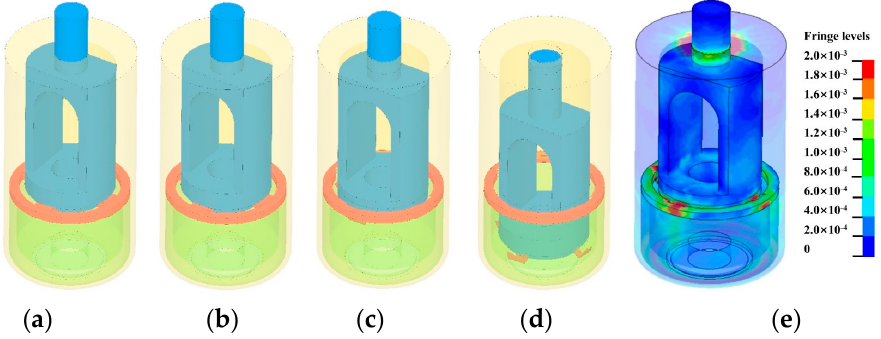
Figure 10. Movement process of the piston: ( a ) t = 0 μ s; ( b ) t = 64 μ s; ( c ) t = 128 μ s; ( d ) t = 200 μ s; ( e ) stress distribution of propellant actuator at a certain time.